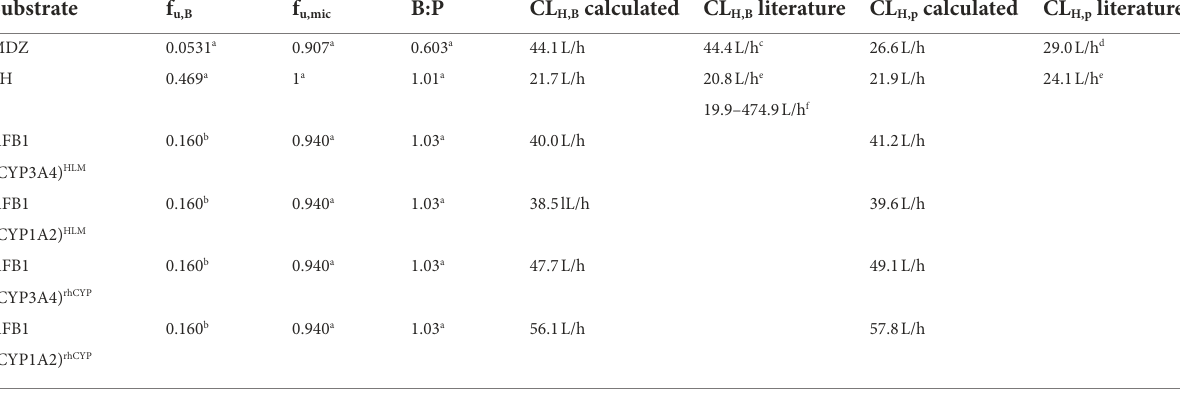
TABLE 5 Overview of the calculated hepatic clearance and the in vivo hepatic clearance retrieved from literature.